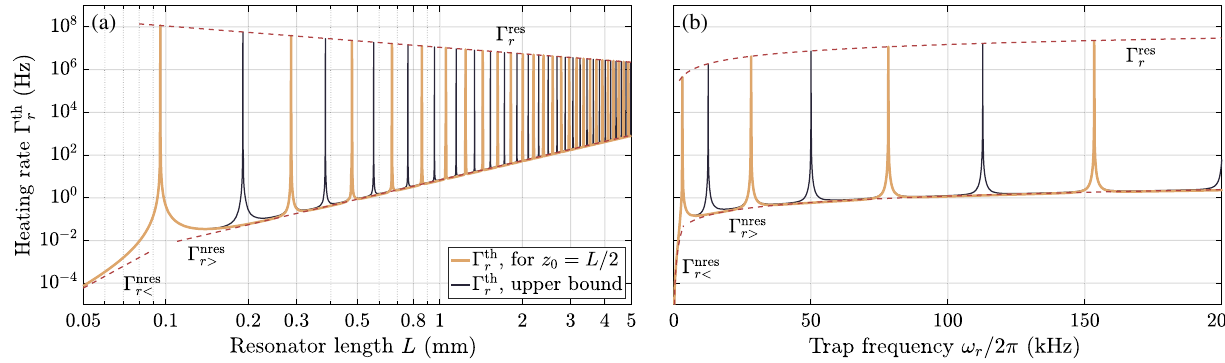
FIG. 2. Atom heating rate in the radial direction due to flexural resonator modes as a function of (a) the resonator length and (b) the trap frequency. In both cases, an exemplary decay rate of κ ¼ 2 π × 1 . 2 Hz is assumed for all resonator modes. The bold yellow line corresponds to the heating rate experienced by an atom trapped at the center of the resonator z 0 ¼ L= 2 calculated according to Eq. (D41). The thin blue line represents a position-independent upper bound obtained by pretending that the atom sits at an antinode of each phonon mode simultaneously: In consequence, no resonance between the atom and resonator is masked by a vanishing position- dependent coupling rate. This approach is useful, since in experiments an entire ensemble of atoms is trapped at various positions along the fiber. The dashed red lines show the approximations Eqs. (17) – (19). Panel (a) assumes a trap frequency of ω panel (b) assumes a resonator length of L ¼ 600 μ